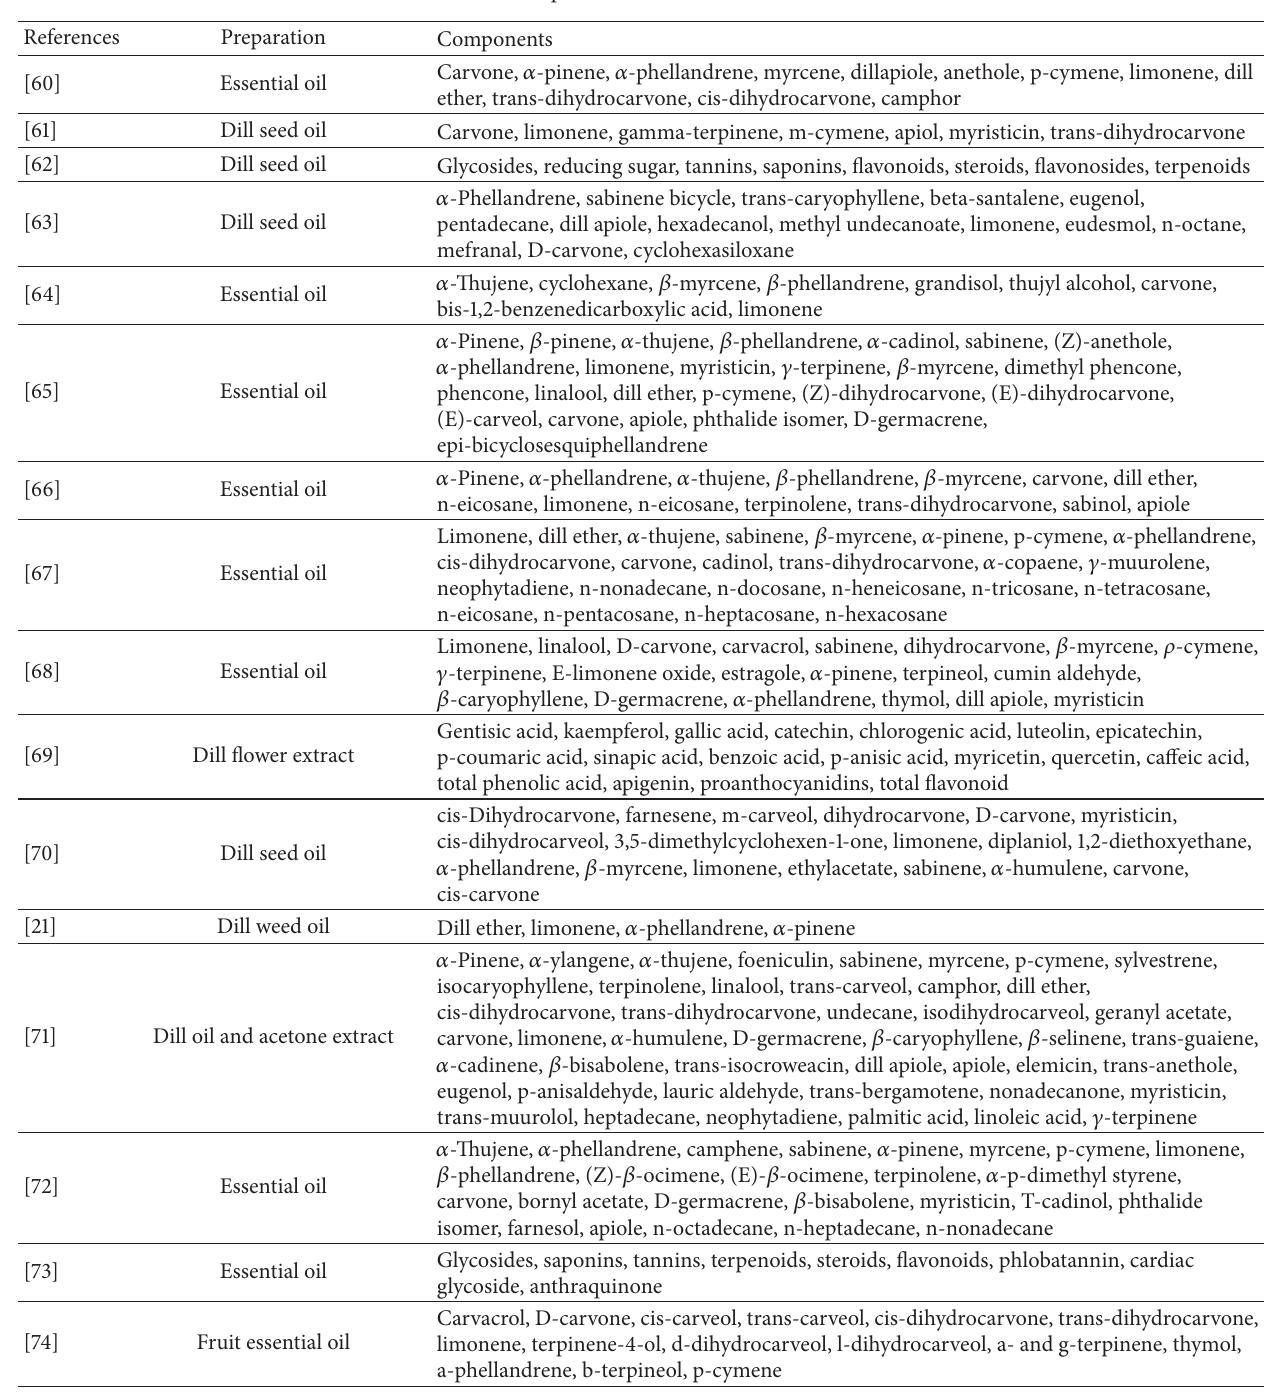
Table 2: Components of AG in different